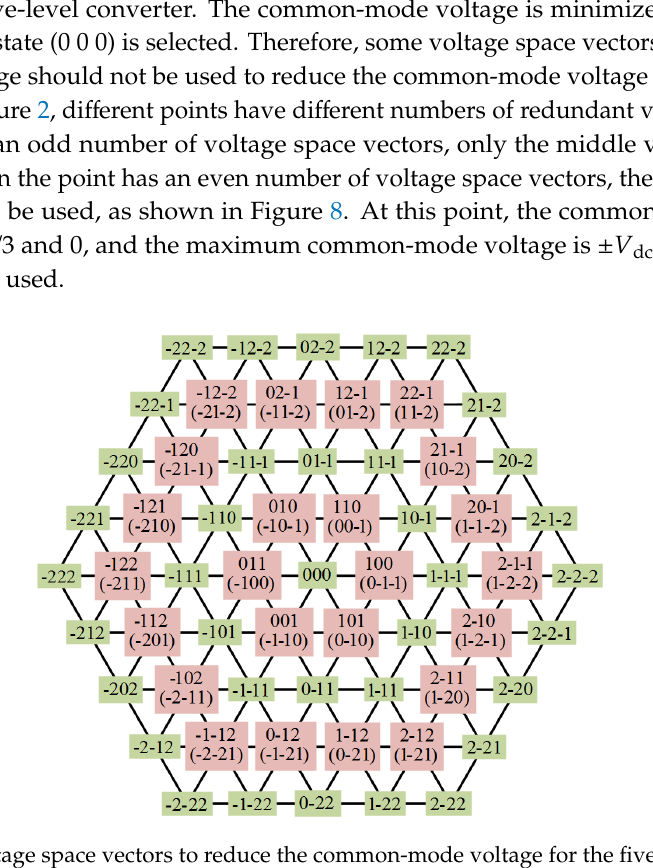
Figure 8. The voltage space vectors to reduce the common-mode voltage for the five-level converter.